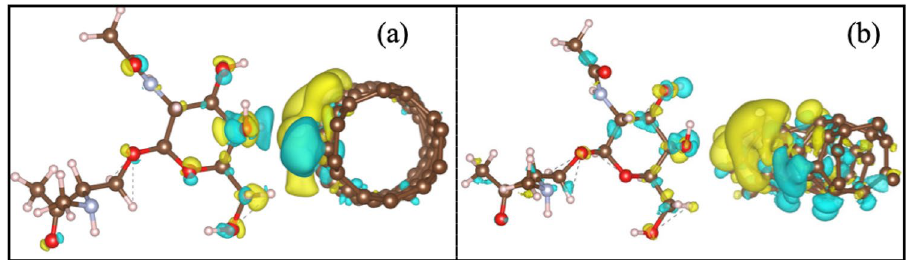
Figure 4. Δρ for ( a ): CNT(4,2) in the presence of an O-linked glycan molecule, ( b ): CNT(3,1) in the presence of an O-linked glycan molecule. Charge accumulation in yellow colour and charge depletion area in blue colour are